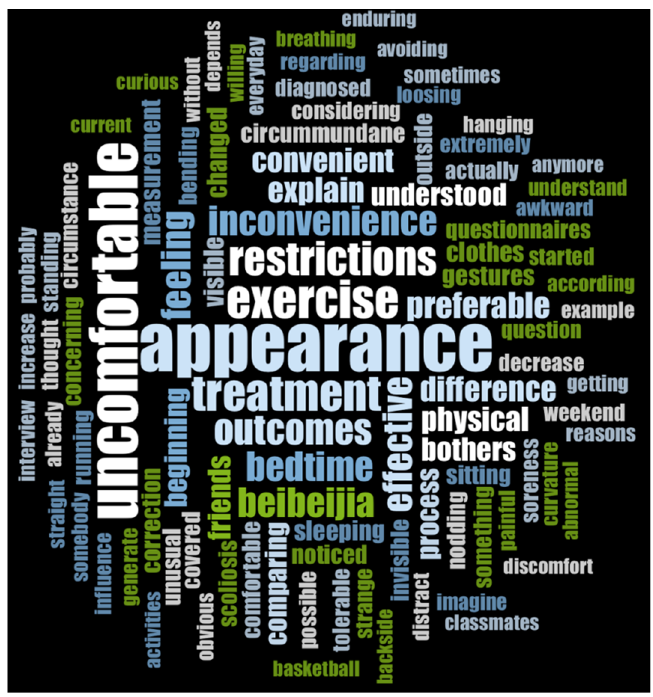
Figure 6. Content analysis on Interview survey.